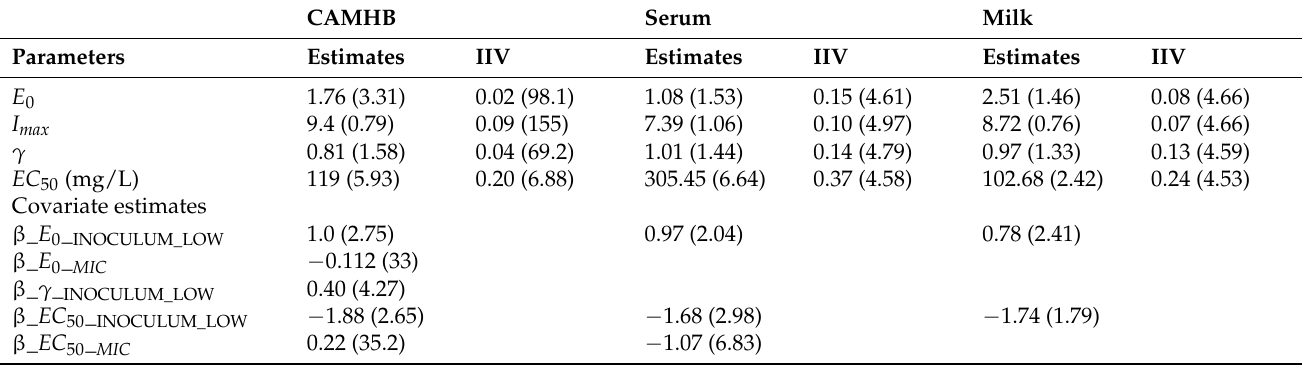
Table 5. Final parameters from inhibitory I MAX model obtained after time kill curves simulated with two population bacterial model for each growth medium used. Data presented as estimates with % RSE, including inter-individual variability